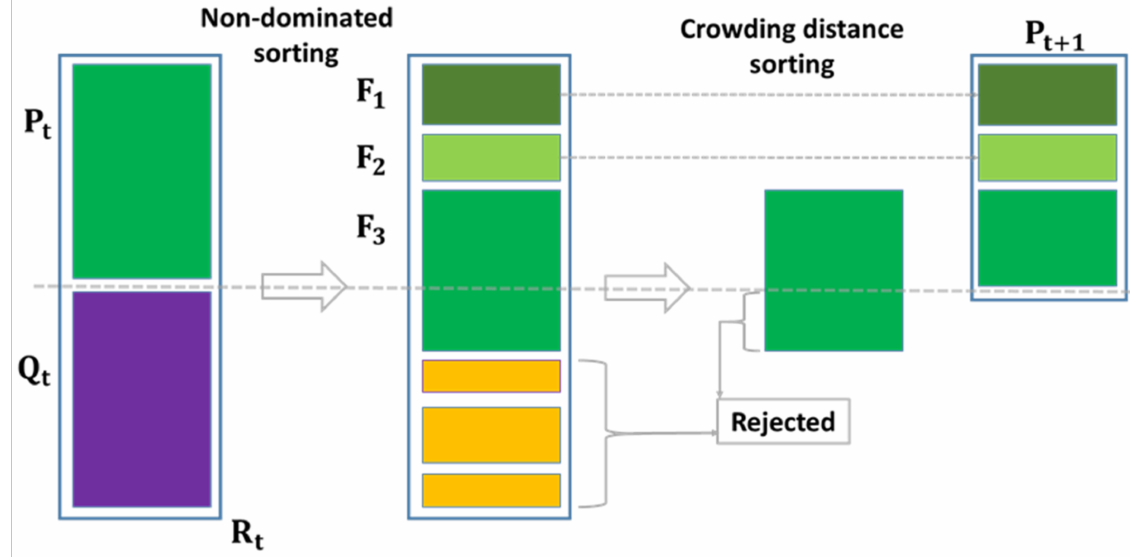
Figure 1. Illustration of the non-dominated sorting algorithm 2 (NSGA II). Qt is the offspring population; Pt is the initial population; Rt is the total population; and F 1 , F 2 , and F 3 are the levels of non-domination